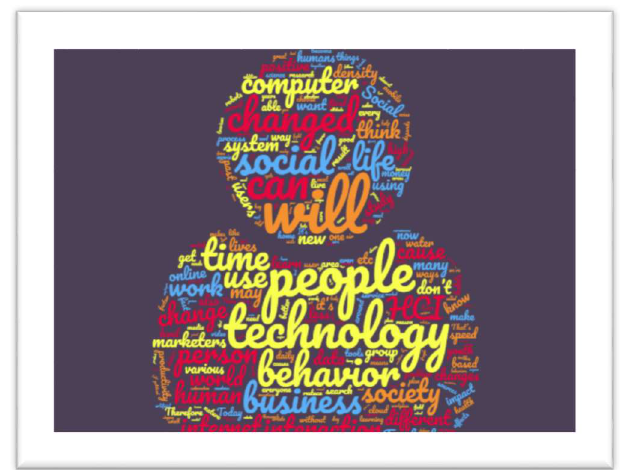
Figure 2. Words cloud of the content of the information about human and